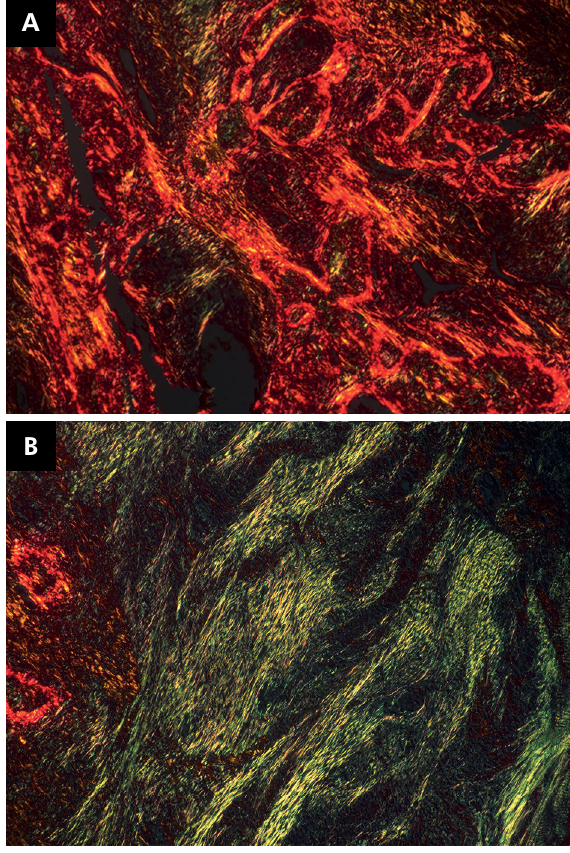
Figure 3. Polarized light photomicrographs: mature collagen fibers appear reddish and yellowish (3A) and immature collagen fibers appear greenish (3B), Picrosirius red staining, 100x.